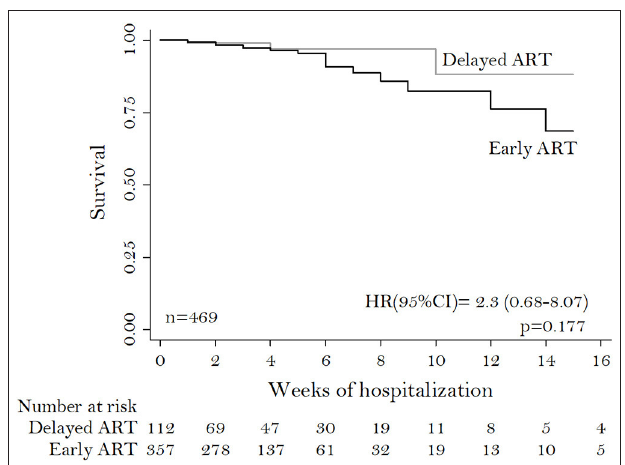
FIGURE 2 | Kaplan-Meier curve of survival of ART-naïve hospitalized patients co-infected with HIV and T. gondii